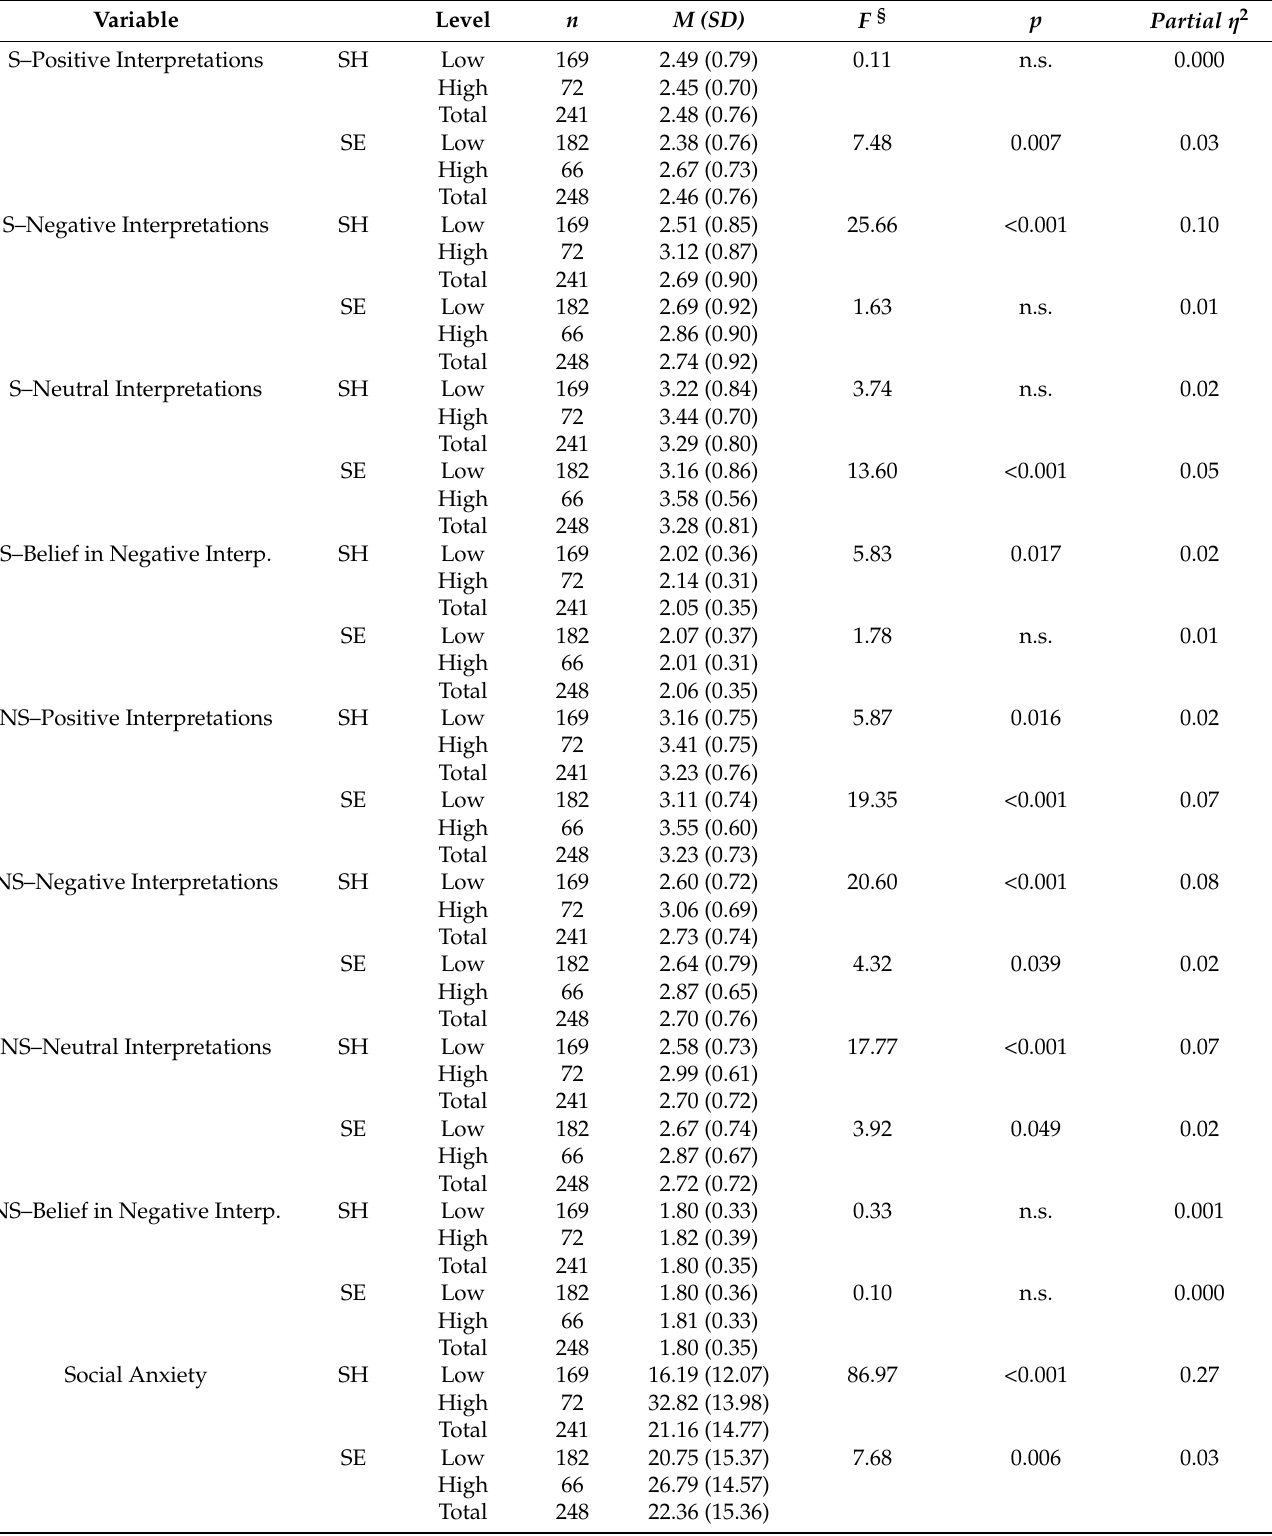
Table 4. Follow-up ANOVAs. AIBQ scales and social anxiety by low and high Studyholism (SH) and Study Engagement